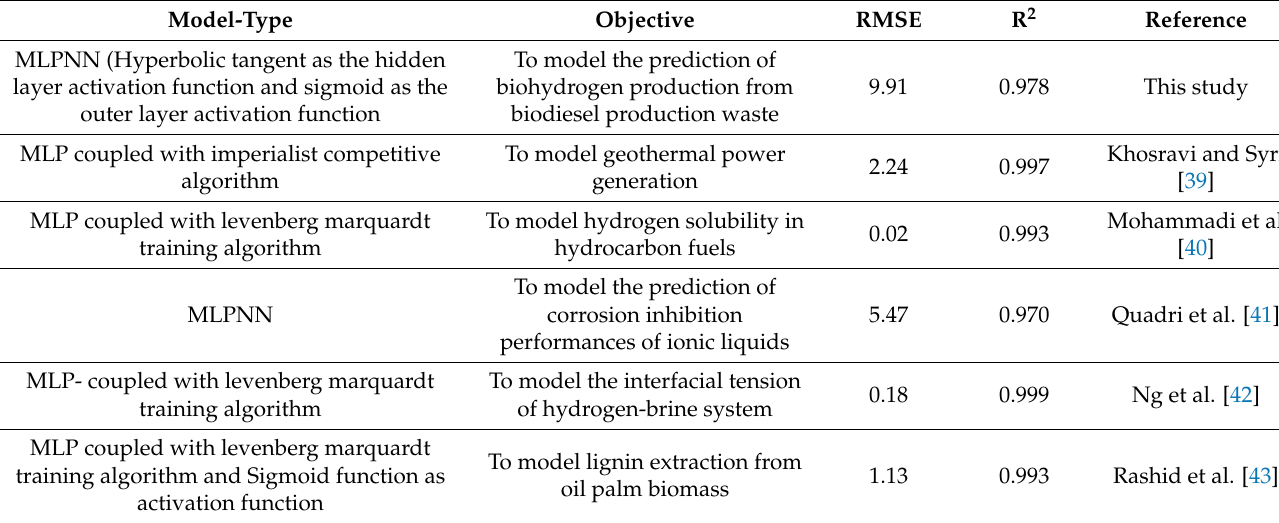
Table 4. Comparison of the best model with the